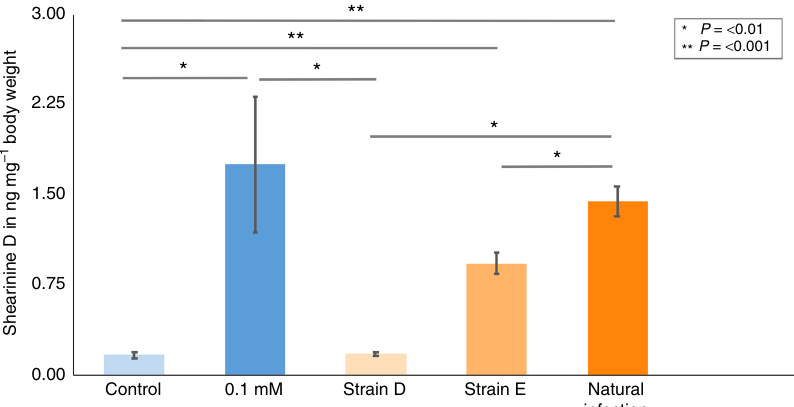
Fig. 7 Accumulation of virulence factor 2 in Acromyrmex ants during nest infection by Escovopsis . Levels of 2 detected in leafcutter worker ants (±s.e.m.) reach biologically relevant concentrations during nest infection by Escovopsis as follows: Acromyrmex echinatior ants fed a 5% glucose solution (control), ants fed a 5% glucose solution containing 0.1 mM 2 , and ants from nests arti fi cially infected with Escovopsis strains D or E, as indicated, and Atta colombica ants from a nest with a natural outbreak of Escovopsis (strain unknown). Lines denote signi fi cant differences between groups, as con fi rmed by Dunn ’ s multiple comparison tests with adjusted P